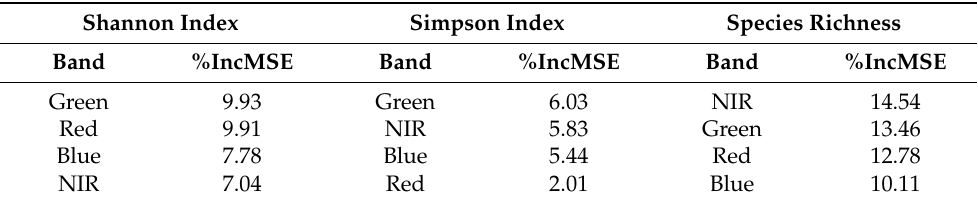
Table 7. Variable importance ranking for the PlanetScope image model under the Shannon Index, Simpson Index and the Species richness.